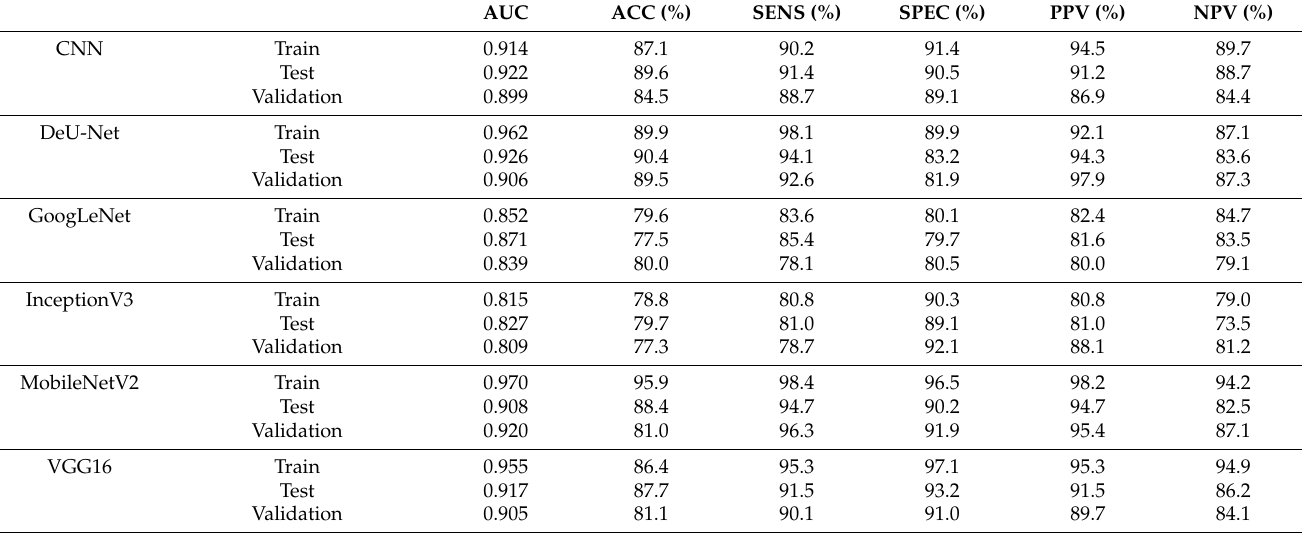
Table 5. Performance of different neural network in training with single modality